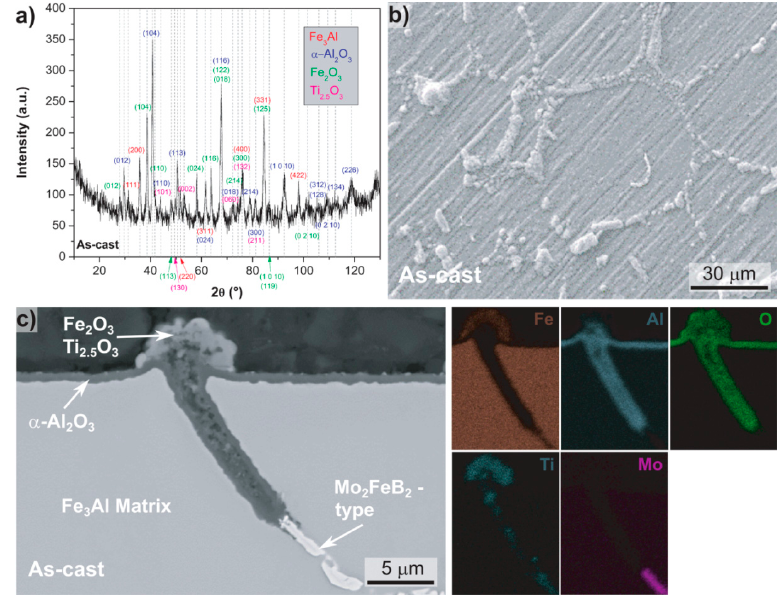
Figure 3. As-cast Fe-25.7Al-2.0Mo-0.6Ti-1.3B after oxidation at 900 °C in synthetic air; ( a ) grazing incidence X-ray diffraction (GI-XRD) spectrum; ( b ) secondary electron (SE)-SEM image of the surface; ( c ) BSE-SEM image of the cross section and the corresponding energy-dispersive spectrometer (EDS) element mappings.